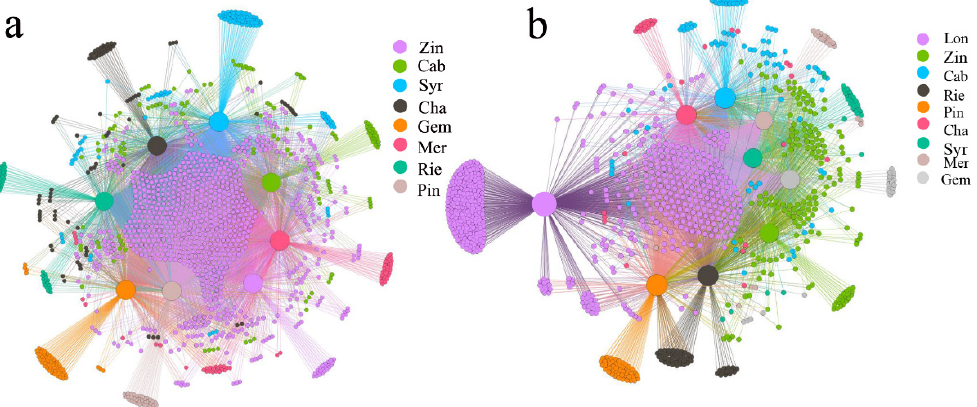
Figure 1. Bipartite network analysis of grape rhizosphere bacterial ( a ) and fungal ( b ) communities. Zinfandel (Zin), Cabernet Sauvignon (Cab), Syrah (Syr), Merlot (Mer), Gem (Gem), Pinot noir (Pin), Riesling (Rie), Longan (Lon), Chardonnay (Cha). The coverage indexes for the bacterial communities and fungal communities were higher than 95% (Table 1) and 99% (Table 2), respectively. For the bacterial communities, there were no significant differences in the Simpson and Shannon indexes among the nine grape variety samples (Table 1). The ACE and Chao1 index of Mer and Pin were signifi- cantly different, while the four indexes of fungal communities were extremely significantly different ( p < 0.05) among the nine wine grapes. Zin showed the highest alpha-diversity of the fungal communities (Table 2). Table 1. The alpha-diversity of bacterial communities.